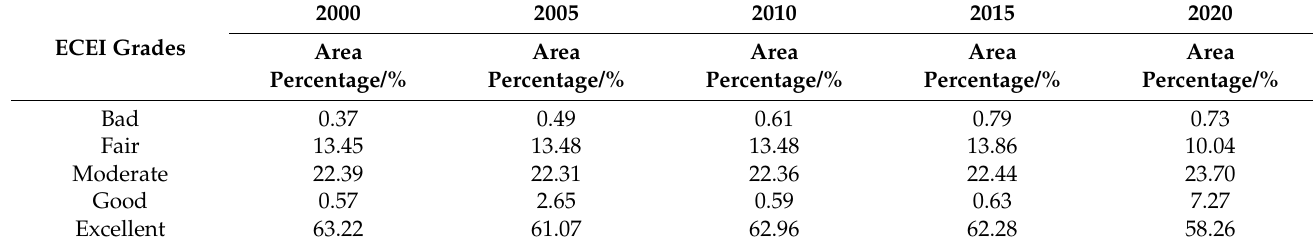
Figure 5. Spatial distribution of ECEI in Zhaotong from 2000 to 2020 at the county level.